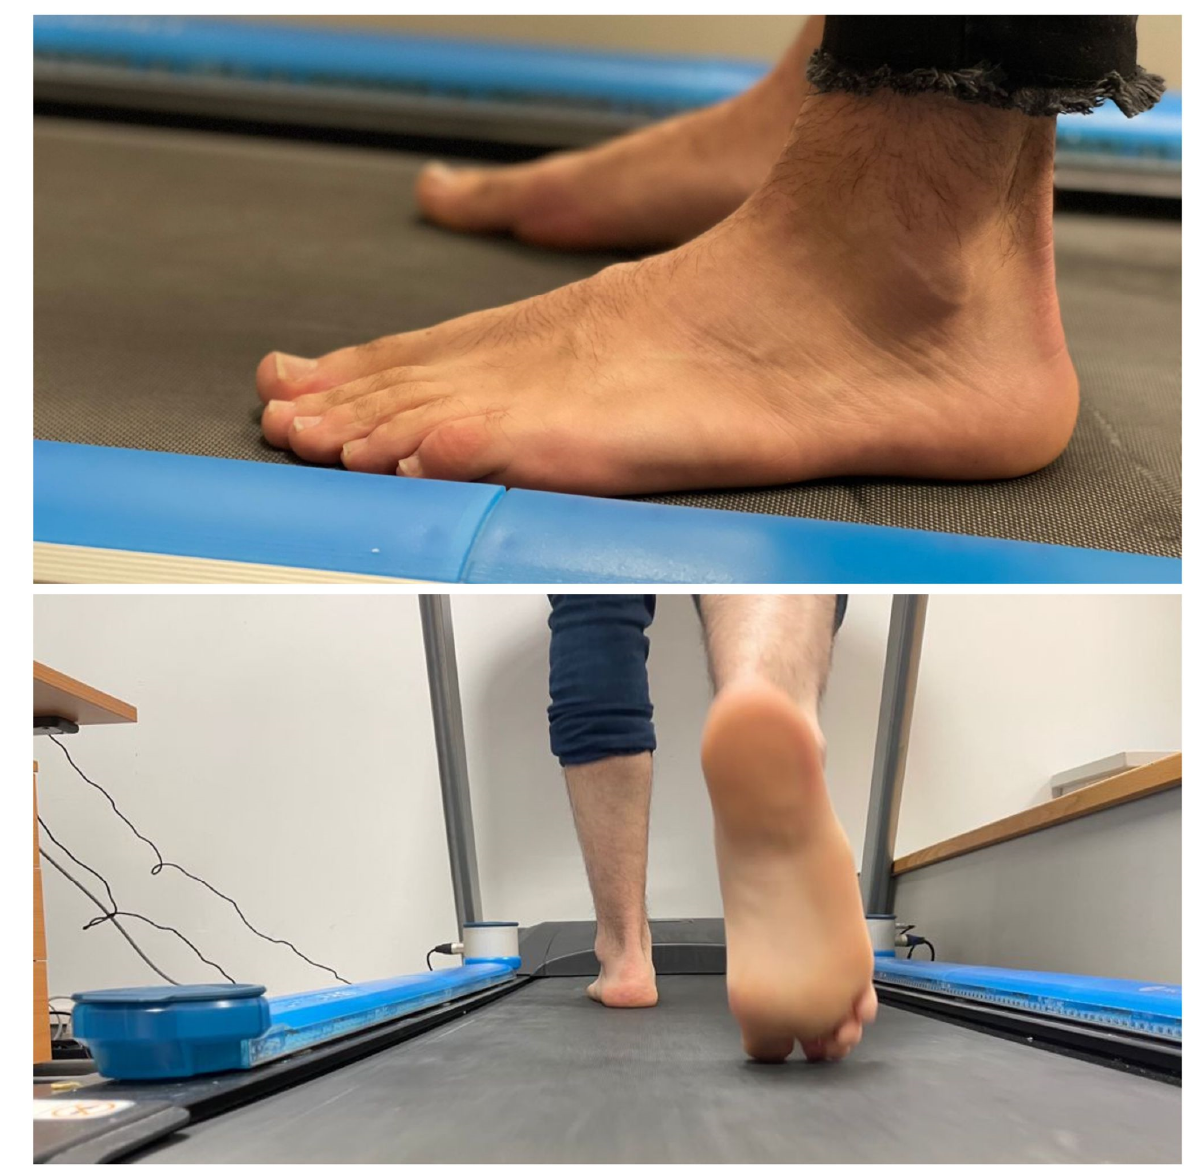
Figure 2. OptoGait treadmill gait analysis.